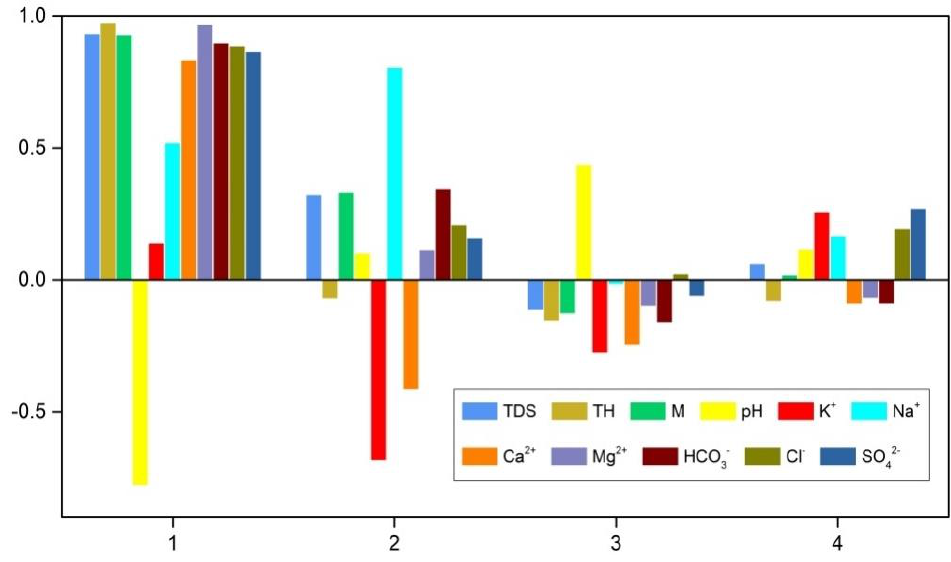
Figure 5. Factor loading values between variable and principal components. Table 3. Factor loading values between variables and principal